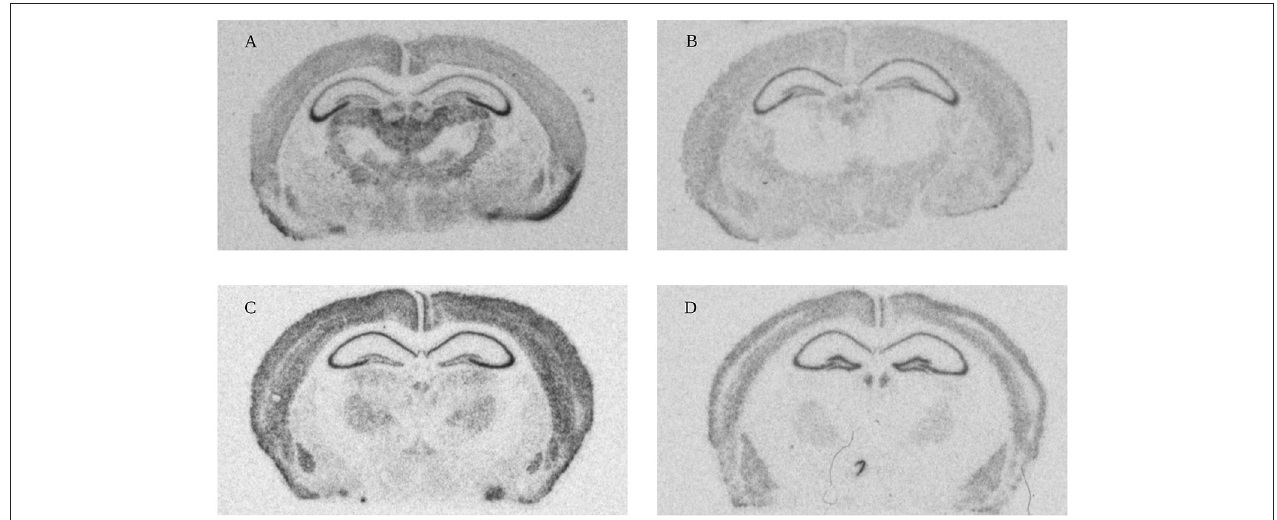
FIGURE 4 | High resolution scans from X-ray film autoradiographs. Representative autoradiograms from in situ hybridization performed with 33 P-labeled oligonucleotides for four different genes ( A : Olfactomedin 1 mRNA 1 week; B : Nogo-A mRNA 2 weeks; C : Lingo-1 mRNA 4 weeks and D : NgR1 mRNA 104 weeks). These scans were used for measurements of gene expression in the 18 different regions ( Figure 3